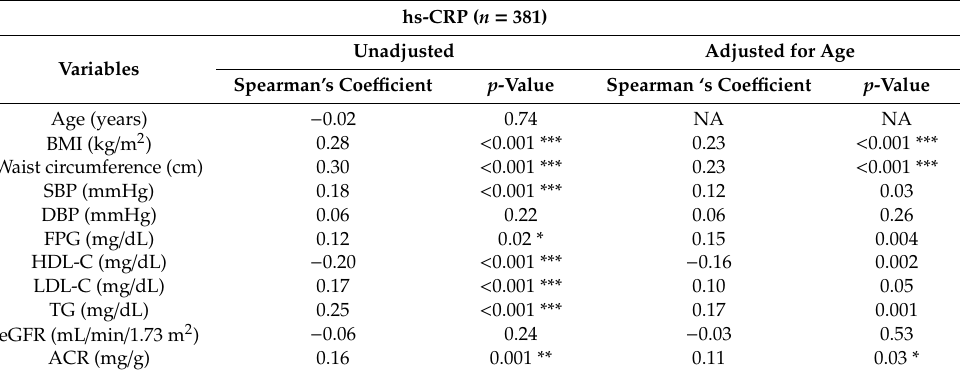
Table 2. Correlation between hs-CRP and cardiometabolic risk